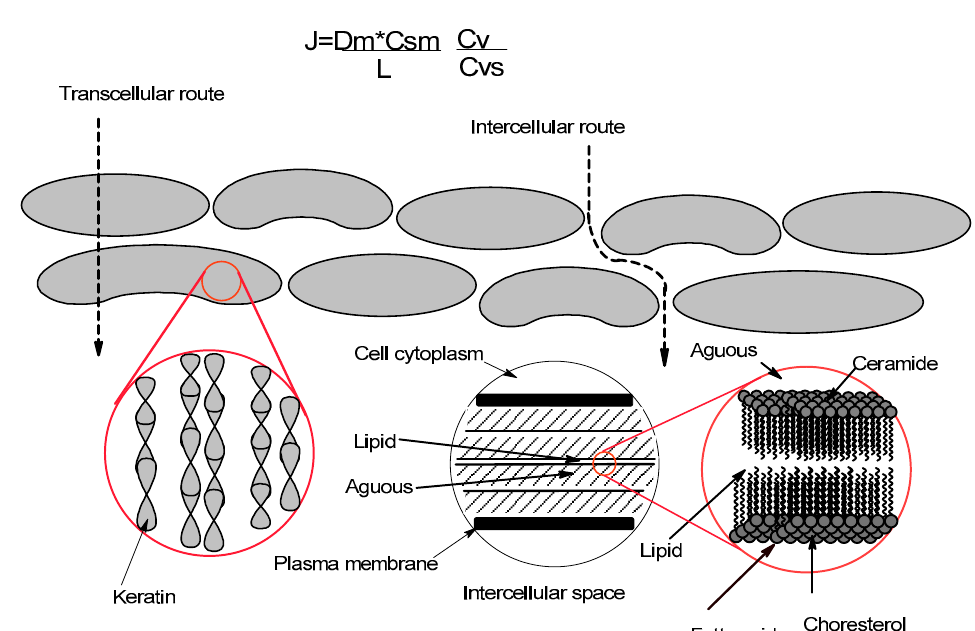
Figure 3 . Permeation routes through the stratum corneum: via the lipid matrix between the corneocytes (intercellular route) and across the corneocytes and the intercellular lipid matrix (transcellular rout) [146].